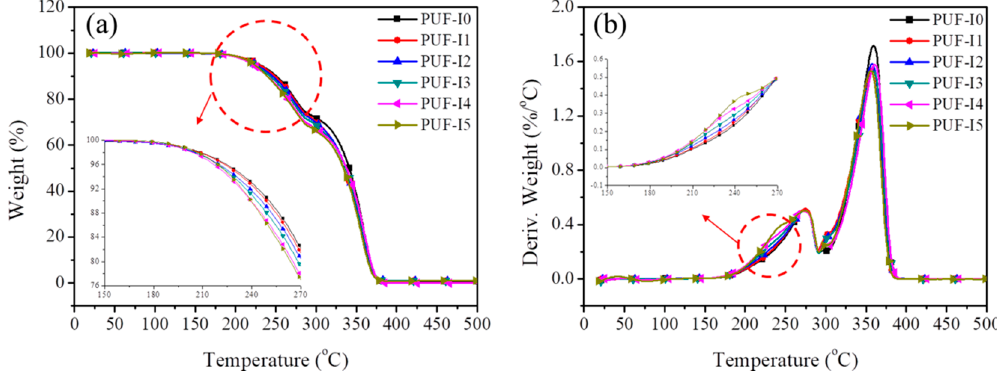
Figure 7. TG ( a ) and DTG ( b ) thermograms of FPUFs containing various amounts of ISB in nitrogen gas atmosphere. Table 4. Characteristic decomposition temperatures of various